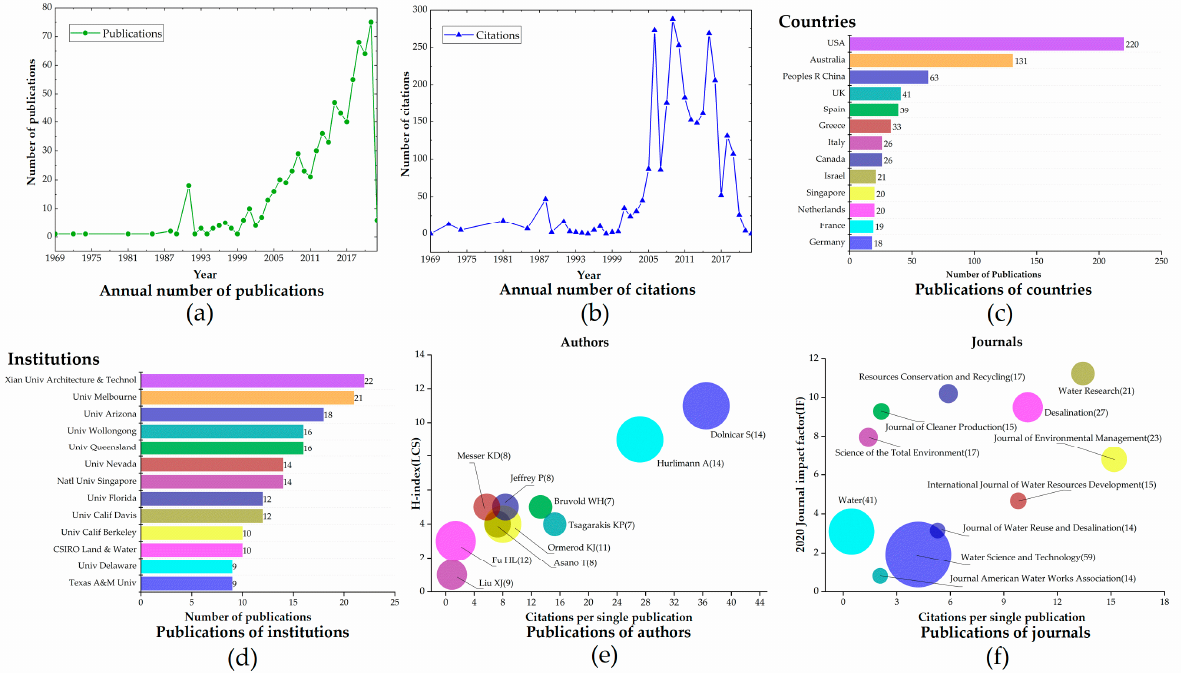
Figure 2. Basic bibliometric analysis of the public acceptance of reclaimed water. (The position of nodes in ( a , b ) represents the number and time. The length of each rectangle in ( c , d ) represents the number of publications. Note that the size of the nodes in ( e , f ) represents the difference in publication numbers. When the area of the nodes is larger, the publication number of the node is greater).